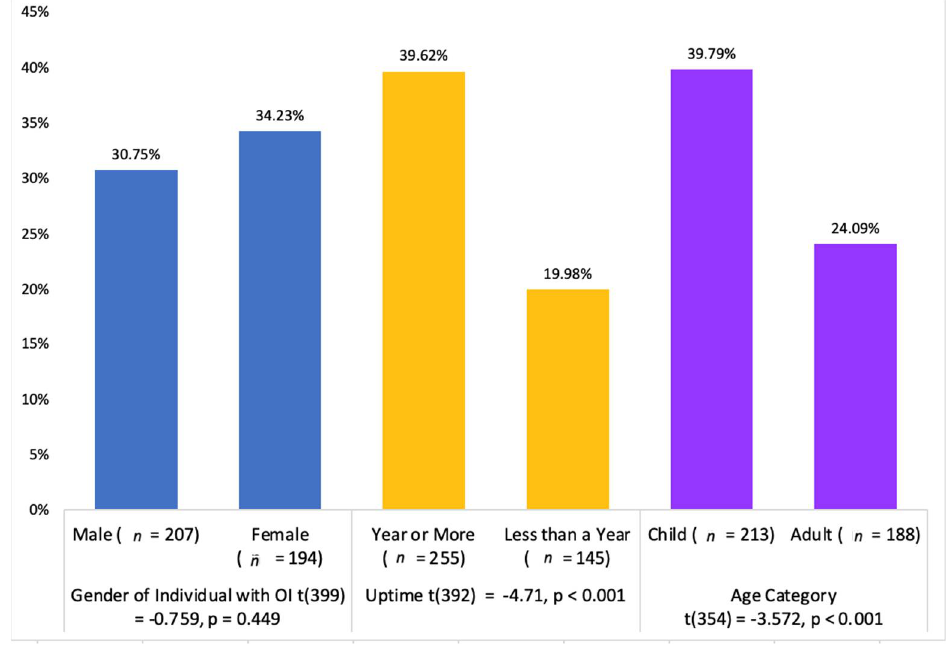
Figure 5. Comparing mean percentage of funding goal achieved for gender, uptime, and